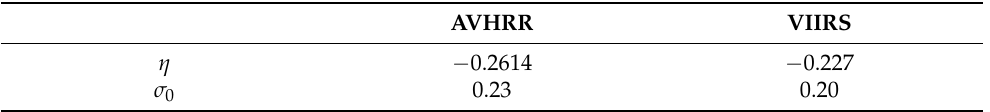
Table 2. The parameters used for quality